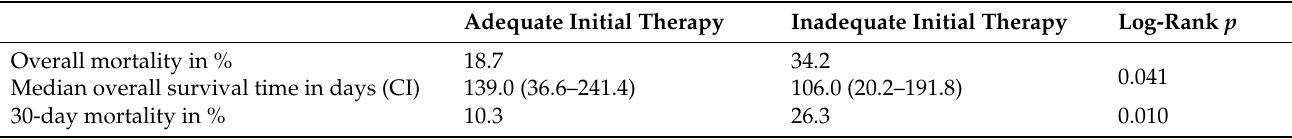
Table 6. Impact of initial therapy on patient survival.